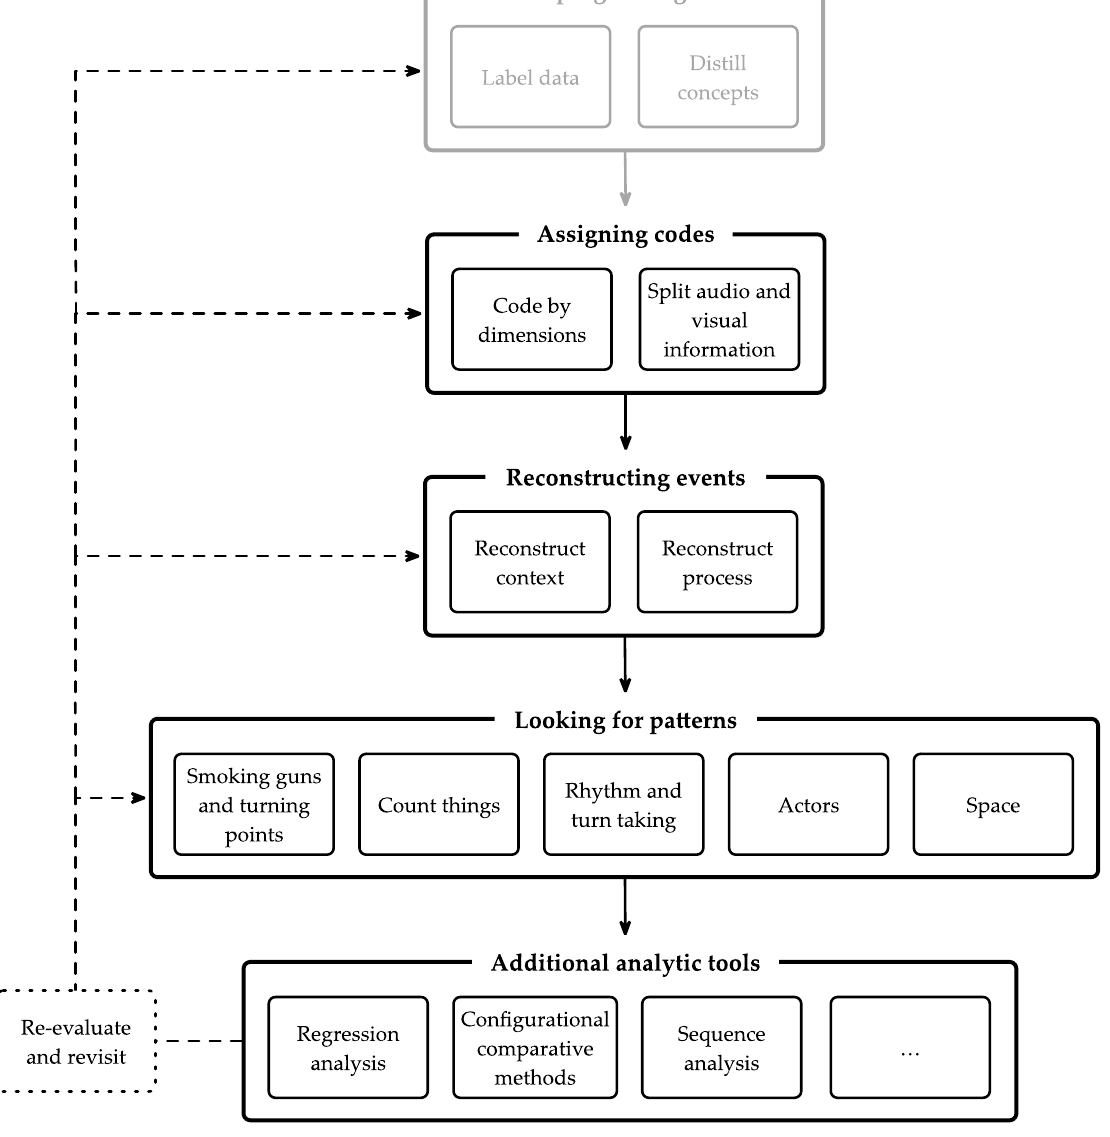
Figure 2. Overview of data analysis in VDA.